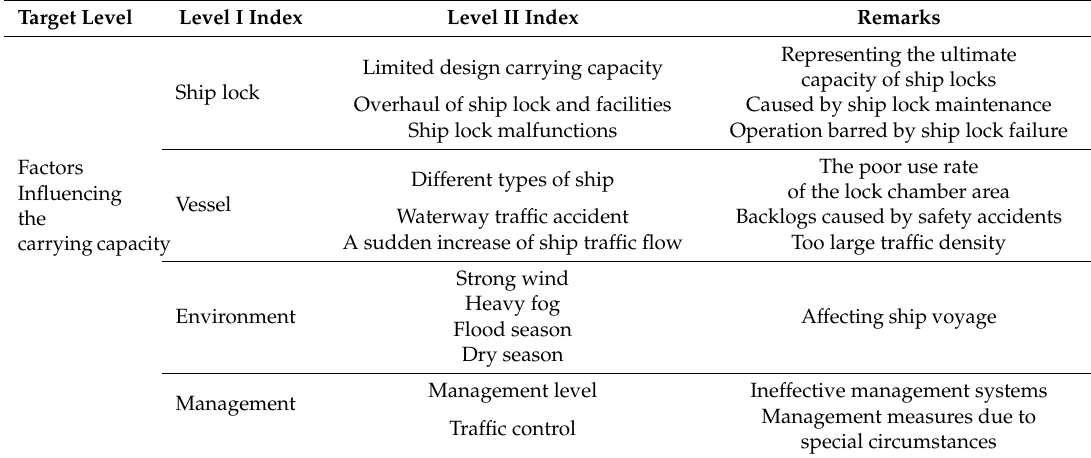
Table 3. The factors influencing the carrying capacity of the Three Gorges Dam.